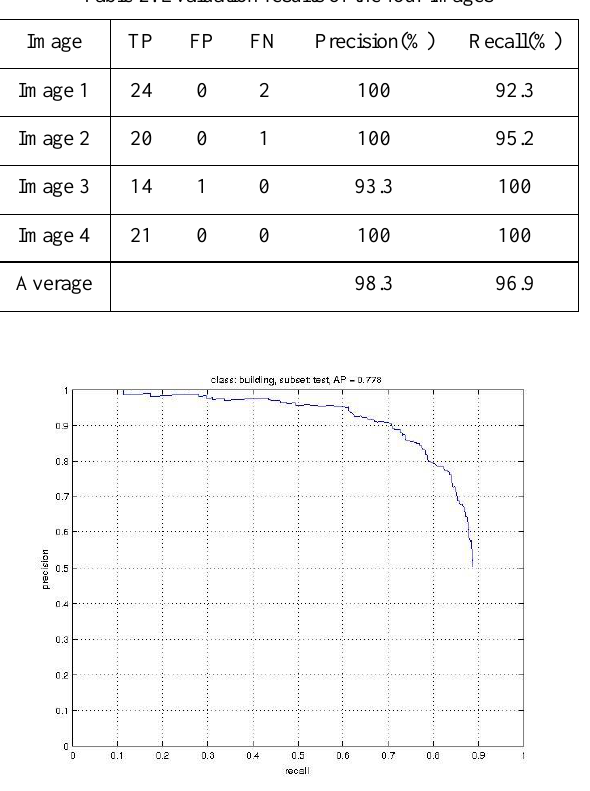
Figure 3. Precision-recall curve of the building detection